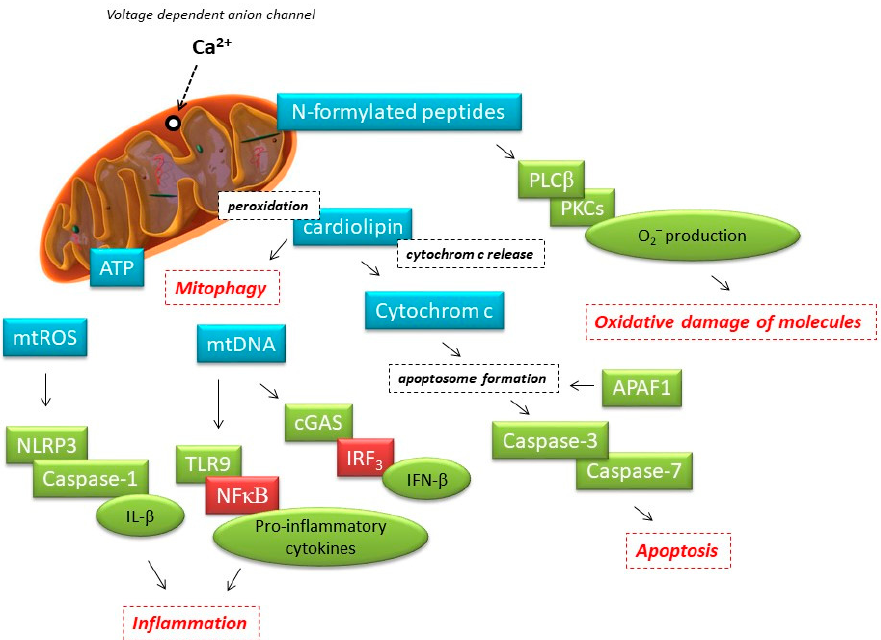
Figure 1. The initiation of intracellular signaling by the interaction of DAMPs or PAMPs with the respective receptors activates constitutive cell-autonomous immunity, representing the primordial innate defence and its functional expression. The internal cell response is initiated by the release of Ca 2+ from the stressed ER that is accepted by mitochondria and initiates the generation of secondary stress signals. They are represented by mtROS, N-formyl peptides, and cardiolipin, as well as cytochrome c released from mitochondria, which finalized the effector mechanisms of the autonomous stress response. Another mitochondrial-damage-associated molecular pattern, ATP, initiates the assembly of the inflammasome(s) and initiates inflammation or autophagy, with dependency on the stressor(s).